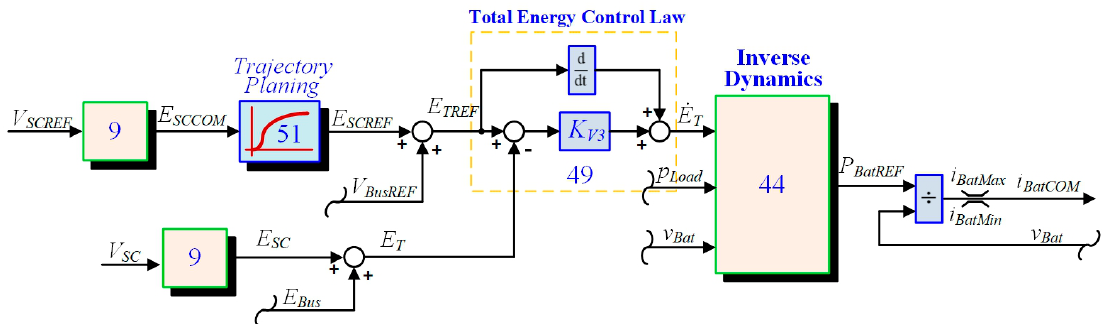
Figure 4. Proposed DC bus energy stabilization.